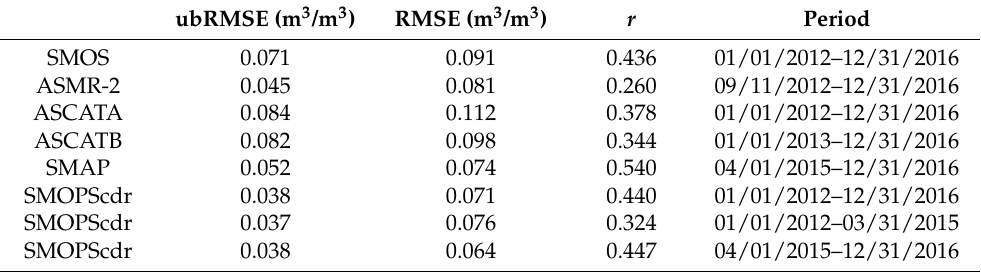
Table 2. With respect to the SMAPVAL soil moisture observations, statistics for studying domain- averaged RMSE, ubRMSE and correlation coefficients ( r ), as well as the corresponding statistical periods for the original individual satellite retrievals and the developed SMOPScdr data product.